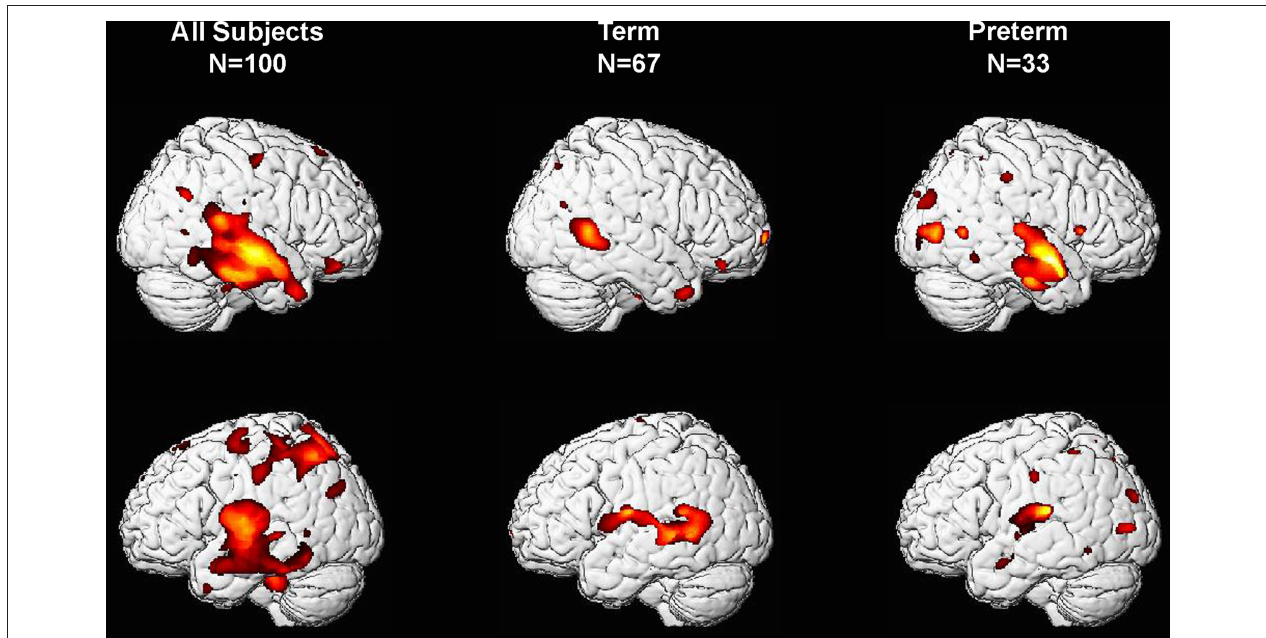
FIguRe 1 | Three-dimensional representation of regions of increased gray matter probability associated with longer gestation for right-handed children born between 28 and 41 weeks. Column 1 presents data from the complete sample, column 2 includes only children born at term (37–41 weeks gestational age) and column 3 includes only children born preterm (28–36 weeks gestational